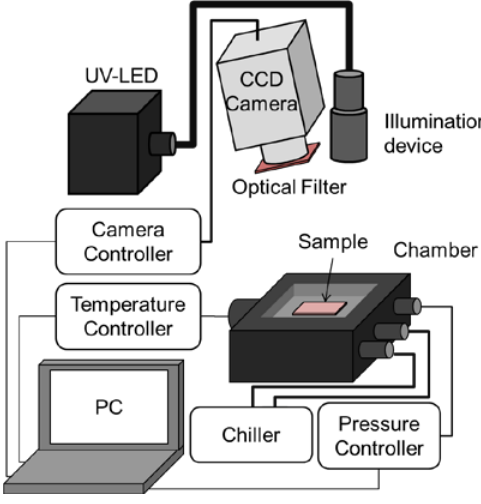
Figure 2. Static calibration system.